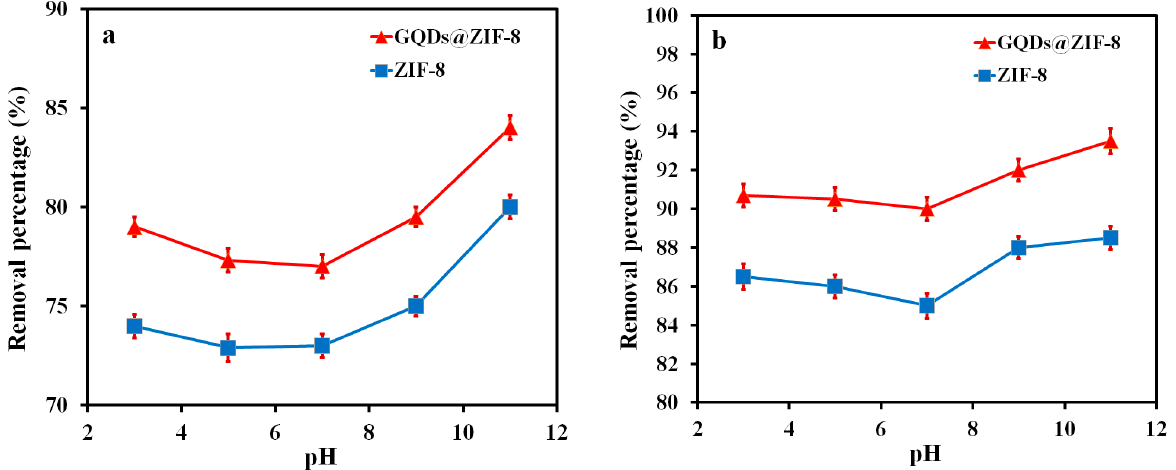
Figure 9. Effect of pH value on removal percentage of toluene ( a ) and ethyl acetate ( b ). To investigate the influence of the contact time on the adsorption property of ZIF-8 and GQDs@ZIF-8 composites, the adsorption capacities of the adsorbent samples at different adsorption times (5, 15, 30, 60, 120, 180 and 360 min, respectively) were recorded and are shown in Figure 10. In this measurement, the sample mass of 100 mg, toluene concentration of 400 mg/L, ethyl acetate concentration of 800 mg/L and pH value of 7 were applied. It can be seen that, within 60 min of contact time, both the adsorption speed and adsorption capacity of the samples to toluene and ethyl acetate increases rapidly. When the contact time is 60 min, the adsorption capacities of ZIF-8 and